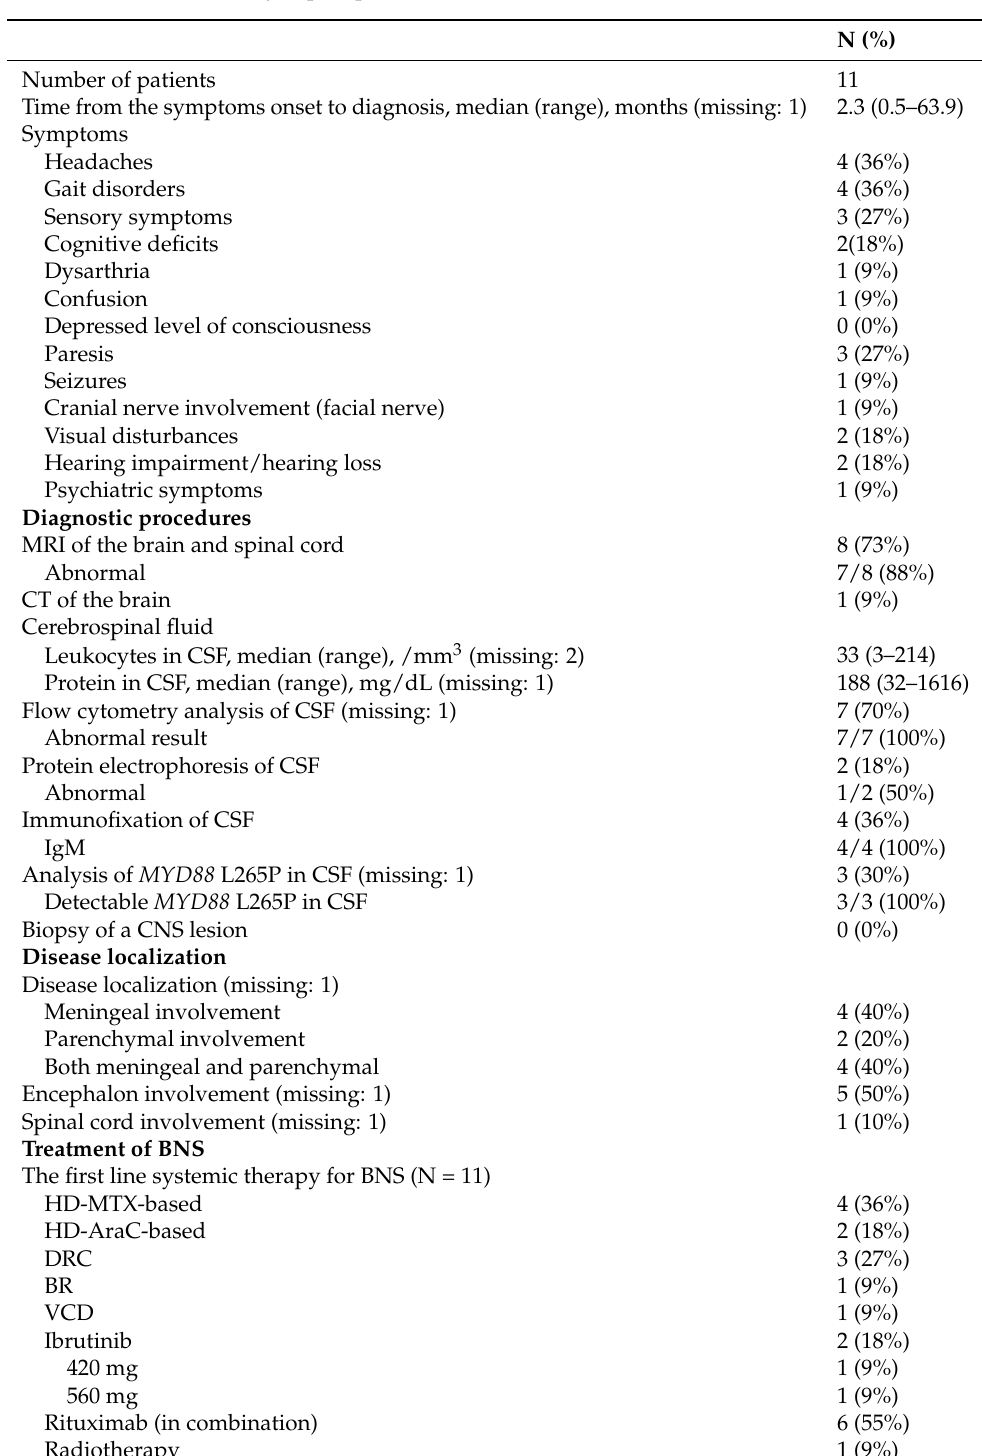
Table 3. Disease characteristics (allo-HCT—allogeneic hematopoietic cell transplantation; AraC— cytarabine; auto-HCT—autologous hematopoietic cell transplantation; BNS—Bing-Neel syn- drome; BR—bendamustine, rituximab; CNS—central nervous system; CR—complete